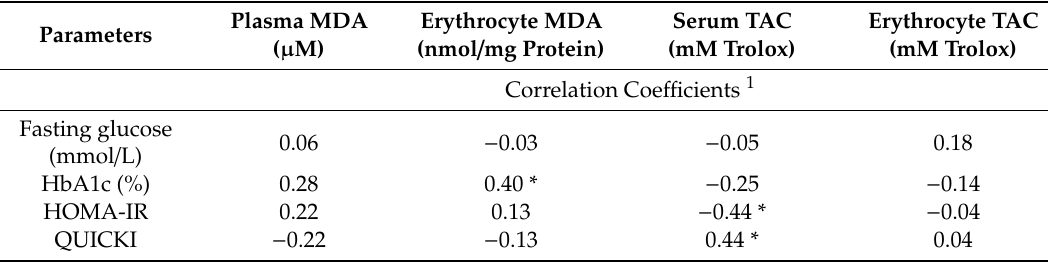
Table 4. Correlations between oxidative stress, antioxidant capacity, and glycemic parameters after